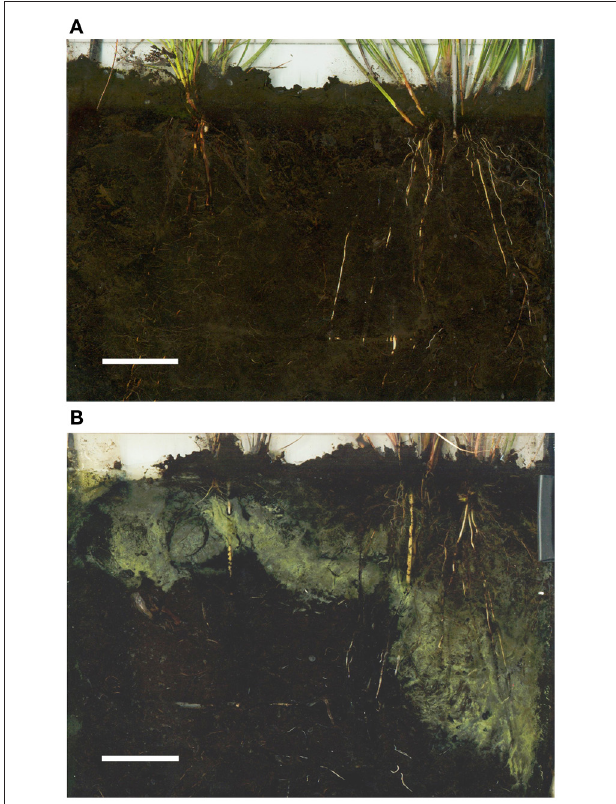
FIGURE 3 | Rhizotron scans for a control (A) and 250 μ mol L − 1 (B) sulfide treatment (darker soil due to FeS x deposits). The oxidation potential is clearly visible from the yellow-gray halo of metallic sulfur and other products of oxidation. In each scan, Carex disticha is positioned left (only shallow S oxidation halos) and Juncus acutiflorus right (deep S oxidation halos). On (B) , two white soil moisture samplers are visible. Bars represent 40mm. Adapted after Lamers (2001) and Lamers et al.